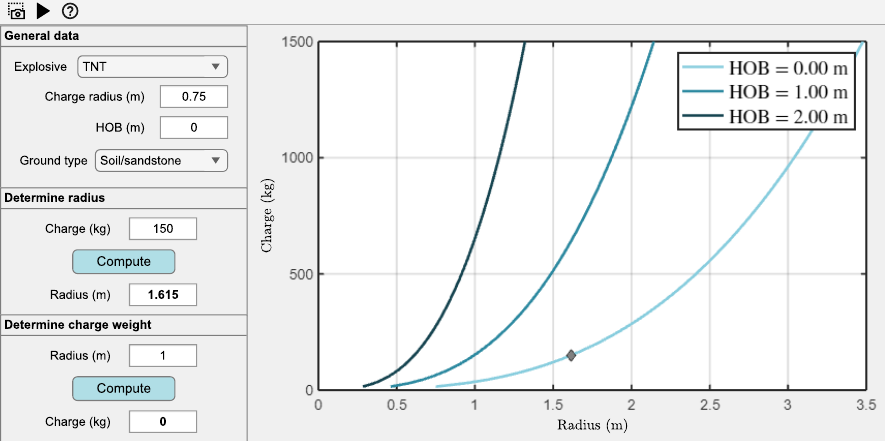
Figure 4. Interface of the assistant for the calculation of craters. HOB denotes the height of